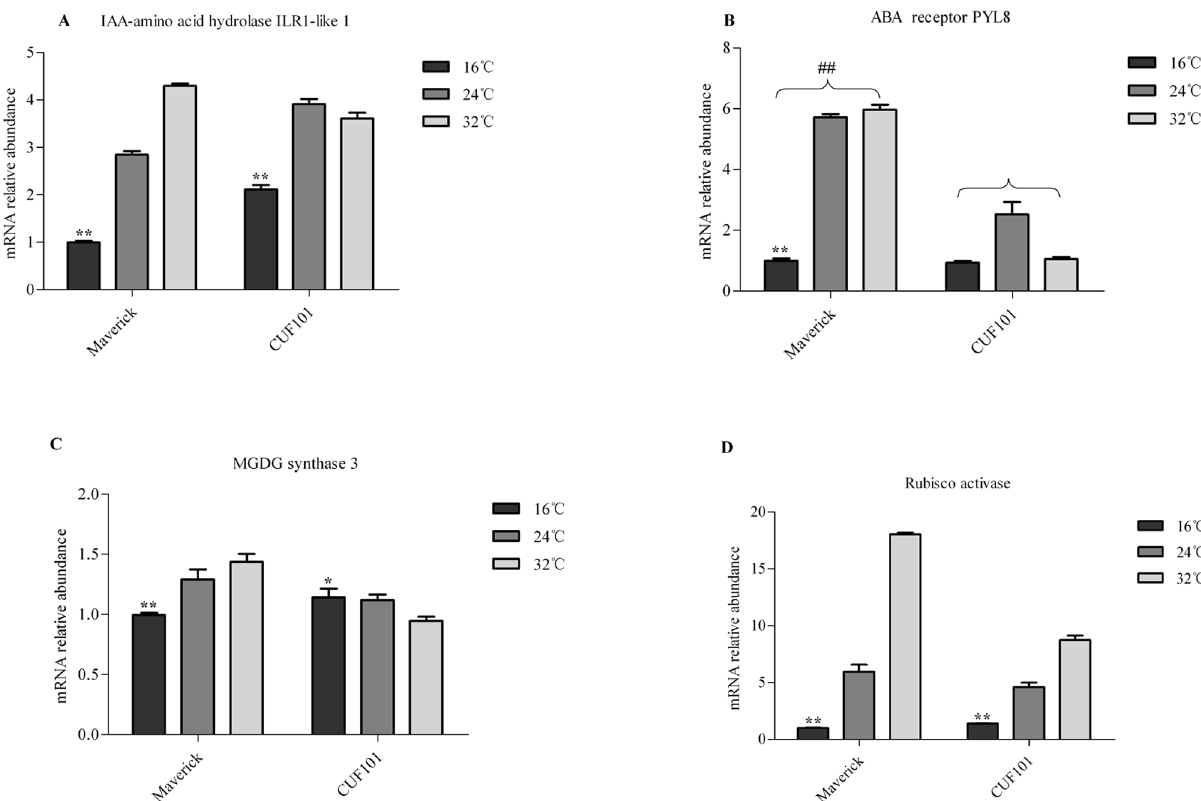
Fig 10. mRNA abundance of four differentially expressedgenes (DEGs) in Maverick and CUF101varietiesgrown under artificial growth conditions at different temperatures (from 32˚C to 16˚C). Significantdifference in mRNA content of DEGs between16˚C, 24˚C and 32˚C for each variety is marked with * . Significantdifference in mRNA content betweenthe two varietiesis marked with # ( * , #, p < 0.05; ** , ##, p < 0.01).Error bars indicate standarddeviation(SD).